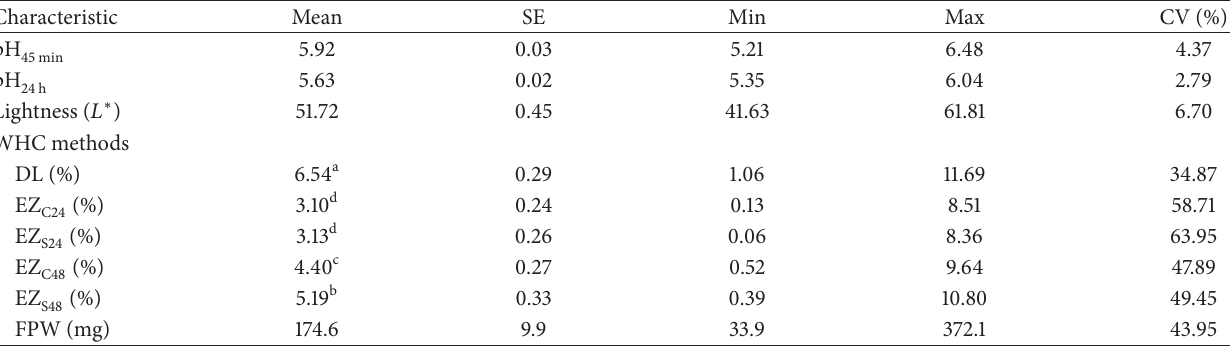
Table 1: Means, standard error (SE), minimum (Min), maximum (Max), and coefficients of variation (CV) for meat quality characteristics measured on pork loin ( Longissimus thoracis muscle; n =